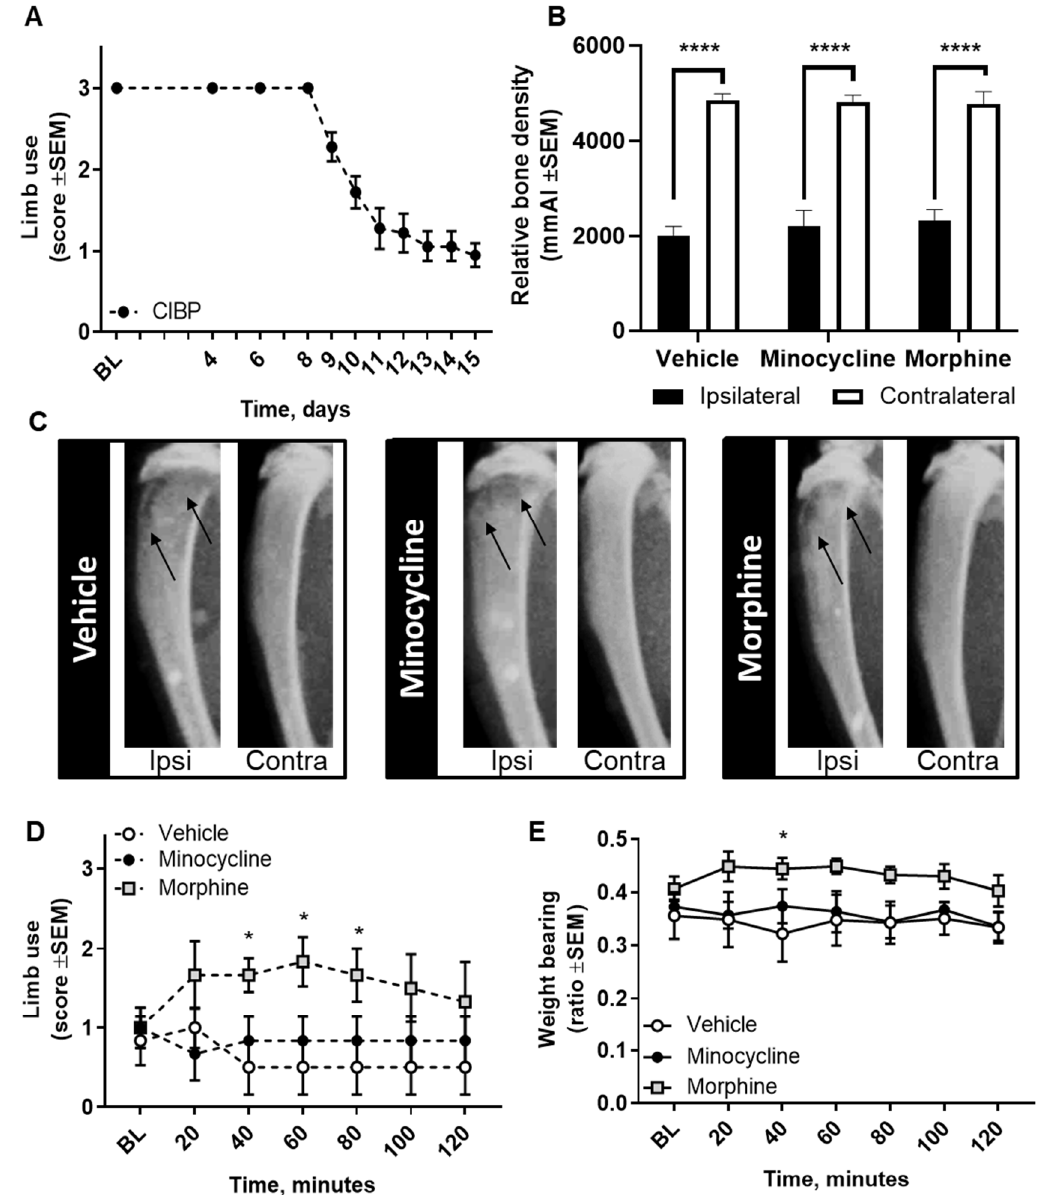
Figure 8. Pharmacological glial modulation in the CIBP model. ( A ) Cancer-bearing rats developed a pain-like phenotype from post-surgical day 8. Upon reaching a limb-use score of 1, rats receive an intrathecal (i.t.) injection of minocycline (100 µ g) or morphine (10 µ g) and their behavior was assessed at 20-min intervals during 2 h. ( B ) At euthanasia, the relative bone density of ipsilateral cancer-bearing tibias was significantly lower than the contralateral tibia in all experimental groups. ( C ) Representative images of the ipsilateral and contralateral tibias of cancer-bearing rats receiving a single intrathecal administration of vehicle, minocycline, or morphine. Arrows indicate areas of bone degradation. ( D ) Spinal administration of minocycline did not alter limb-use scores, while morphine administration induced anti-nociception 40 to 80 min after administration. ( E ) Similarly to the limb-use test, intrathecal minocycline did not alter the weight-bearing ratio, but spinal morphine administration caused a significant increase 40 min after administration and showed a positive trend 60 min after administration ( p = 0.0574). ( B – E ) Vehicle-treated n = 6; minocycline-treated n = 6; morphine-treated n = 6. * p < 0.05; **** p < 0.0001. Data are presented as mean ± SEM. BL: